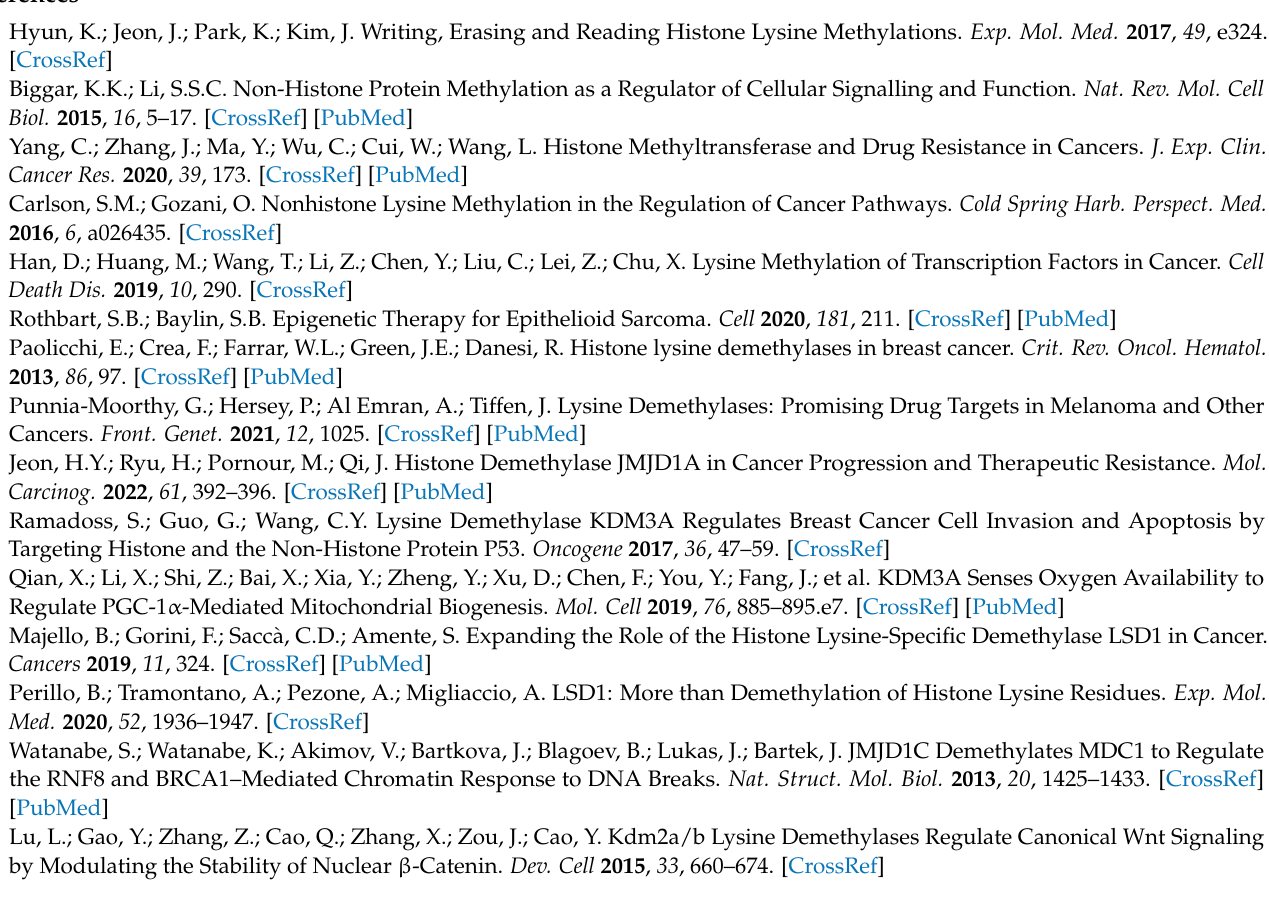
KDM3A substrate specificity profiles associated with Figure 3B; Table S2: Top scoring K-centered windows within the KDM3A interactome; Table S3A–C: Full scoring of KDM3A interactome peptides; Table S4A–C: KDM3A interactome proteins and K-centered 9-mer windows; Table S5: Tabular form of the protein–protein association network depicted in Figure